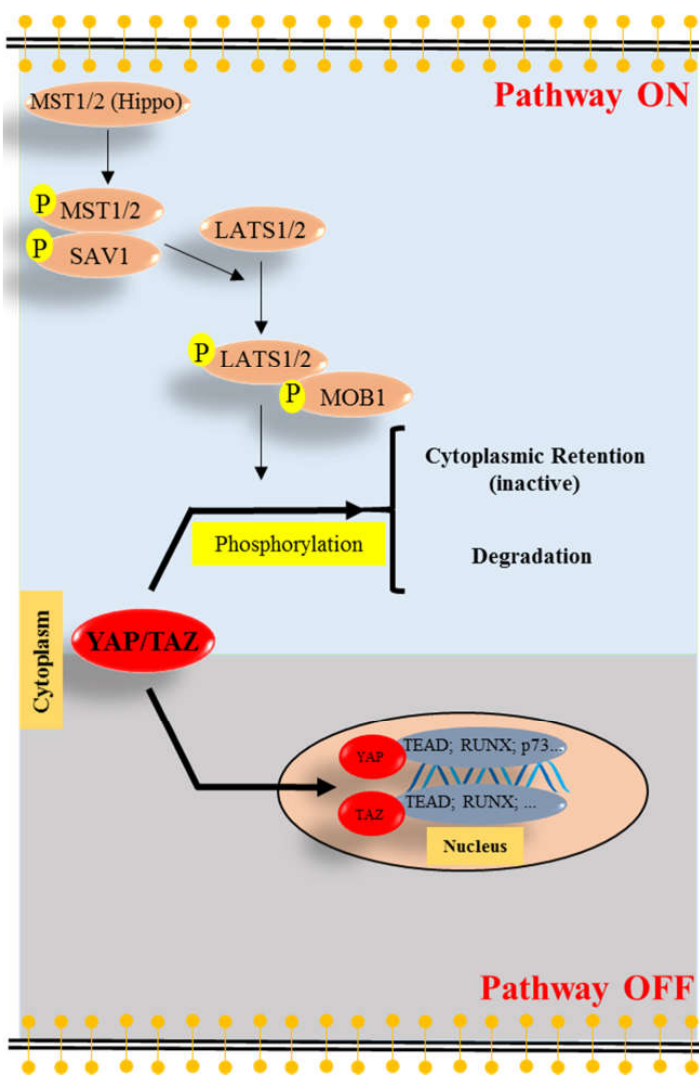
Figure 1. Components of the Hippo-YAP signaling pathway. When the pathway is switched “ON” (blue background), activated mammalian sterile 20-like kinases (MST1 and MST2, MST1/2) and Salvador homolog 1 (SAV1) phosphorylate and activate the large tumor suppressor kinases (LATS1 and LATS2, LATS1/2). The activated LATS1/2 and MOB kinase activators 1 (MOB1) phosphorylate yes-associated protein (YAP) or the transcriptional coactivator with PDZ-binding motif (TAZ), leading to YAP/TAZ cytoplasmic retention (inactive) and degradation. When the pathway is switched “OFF” (gray background), YAP/TAZ accumulates in the nucleus and forms complexes with some transcription factors such as TEA domain (TEAD) family transcription factors, runt-related transcription factors (RUNX) and p73. Arrow: Increase